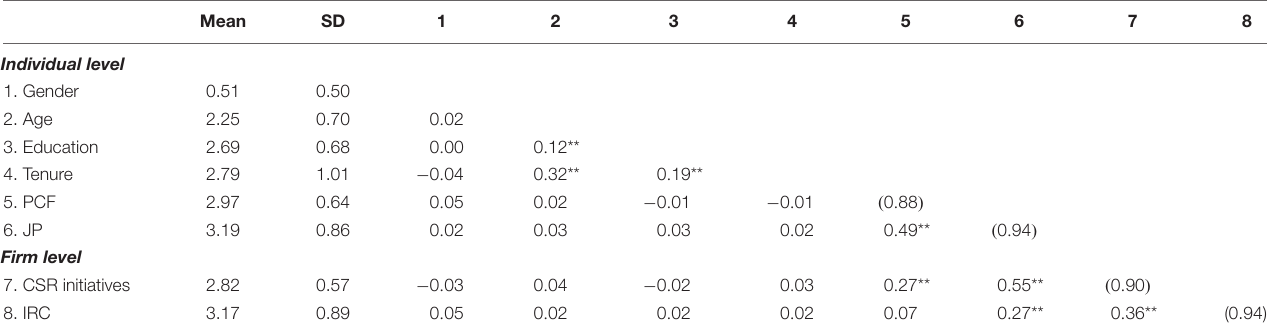
TABLE 3 | Means, standard deviation, and correlations among variables.